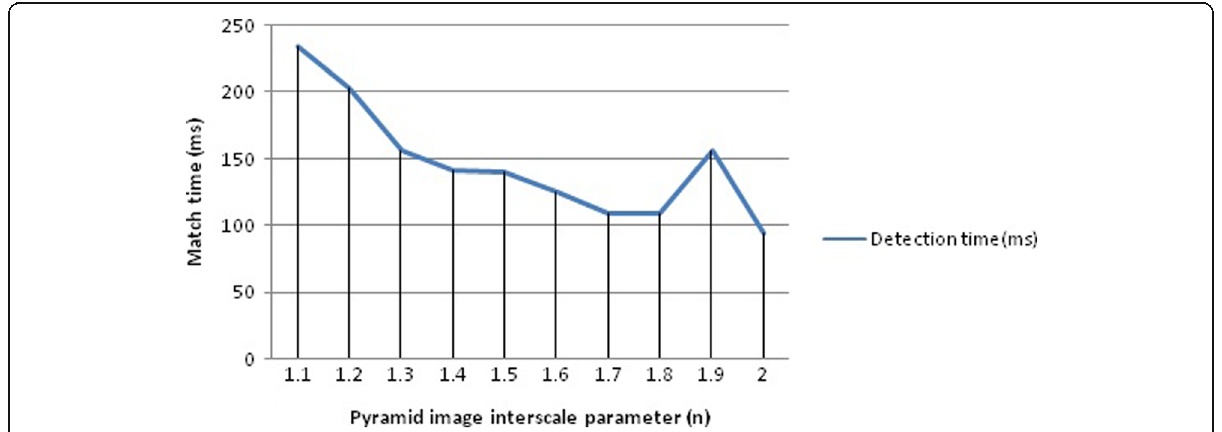
Fig. 12 Time-dependent relationship between scale parameter variation and feature detection in pyramid